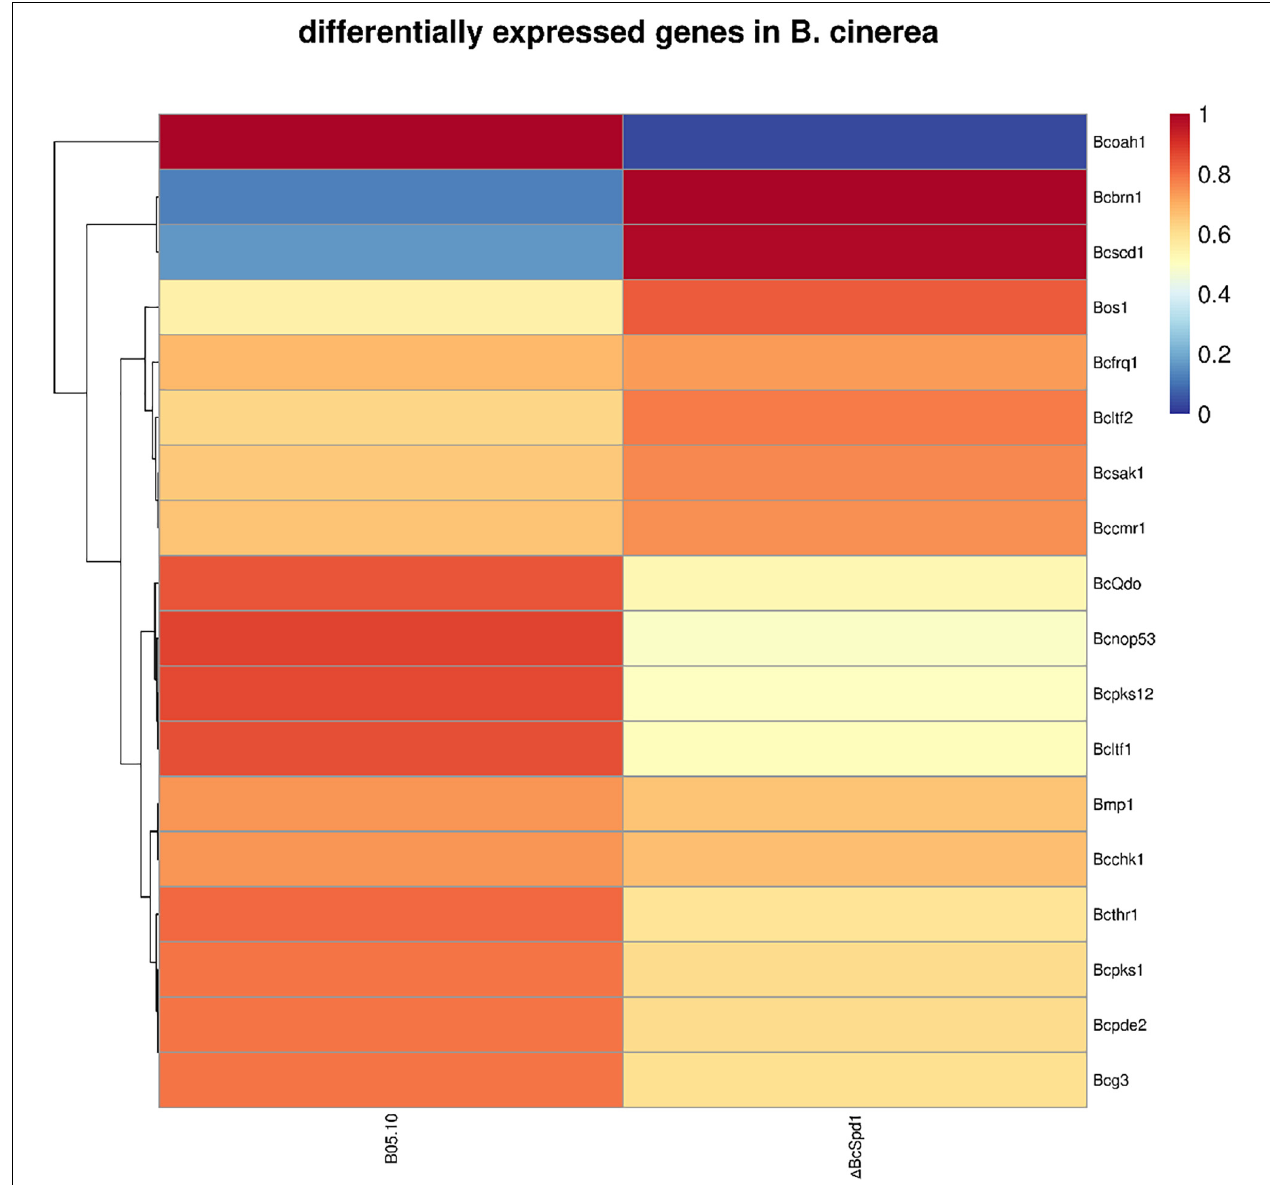
FIGURE 5 | A heatmap analysis of differentially expressed genes involved in B. cinerea development and virulence between the wild-type strain B05.10 and (cid:49) BcSpd1